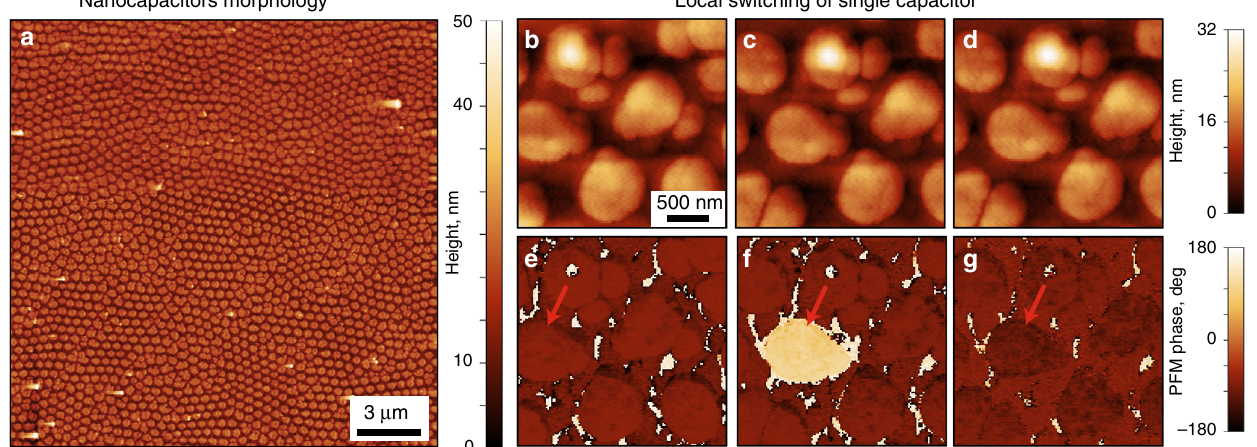
Fig. 1 AFM studies of PZT nanocapacitors. a Topography of the pristine sample. b – g Polarization switching of a single capacitor via an AFM tip: b , e before switching; c , f switching with + 4 V; d , g back switching with − 4 V. Signals of b – d topography and e – g PFM phases